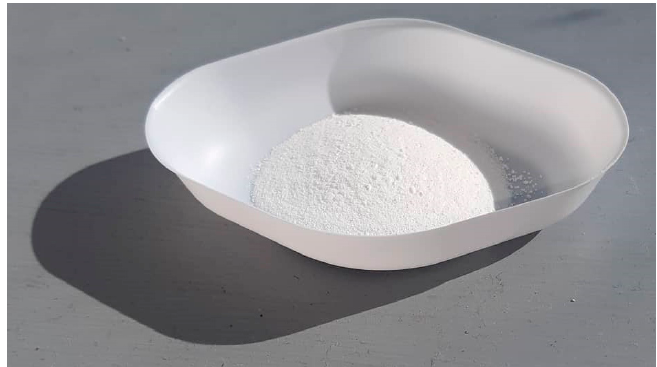
Figure 9. Dextran from Leuconostoc mesenteroides , Megazyme (Ireland).